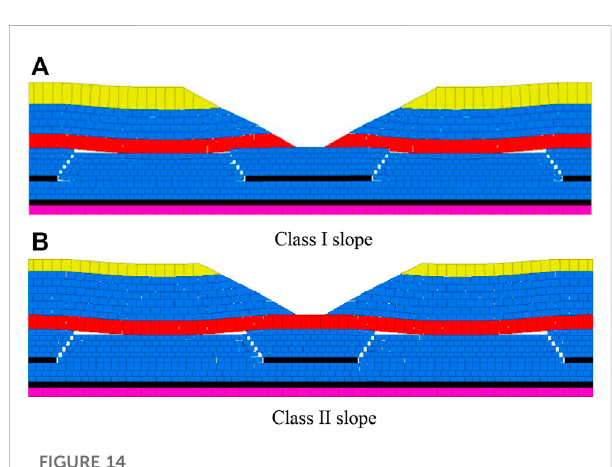
FIGURE 14 Overburden evolution characteristics with safety pillar. (A) Class I slope. (B) Class II